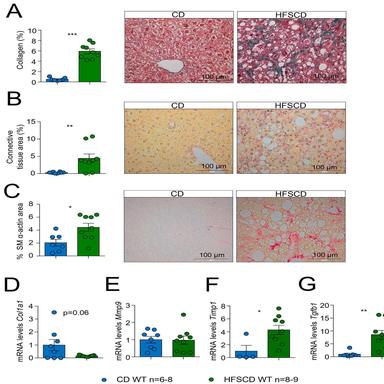
HFSCD-fed WT mice develop fibrosis and altered fibrotic gene expression. Area percentages of (A) collagen detected with Masson's trichrome staining, (B) connective tissue detected with ponceau S-picric acid solution and (C) SM-α-actin staining for hepatic stellate cell (HSC) activation. Representative images of the of the staining's are shown next to the quantifications for both dietary regimens. mRNA levels of (D) Col1a1, (E) Mmp9, (F) Timp1 and (G) Tgfb1 genes. mRNA expression levels were normalized with